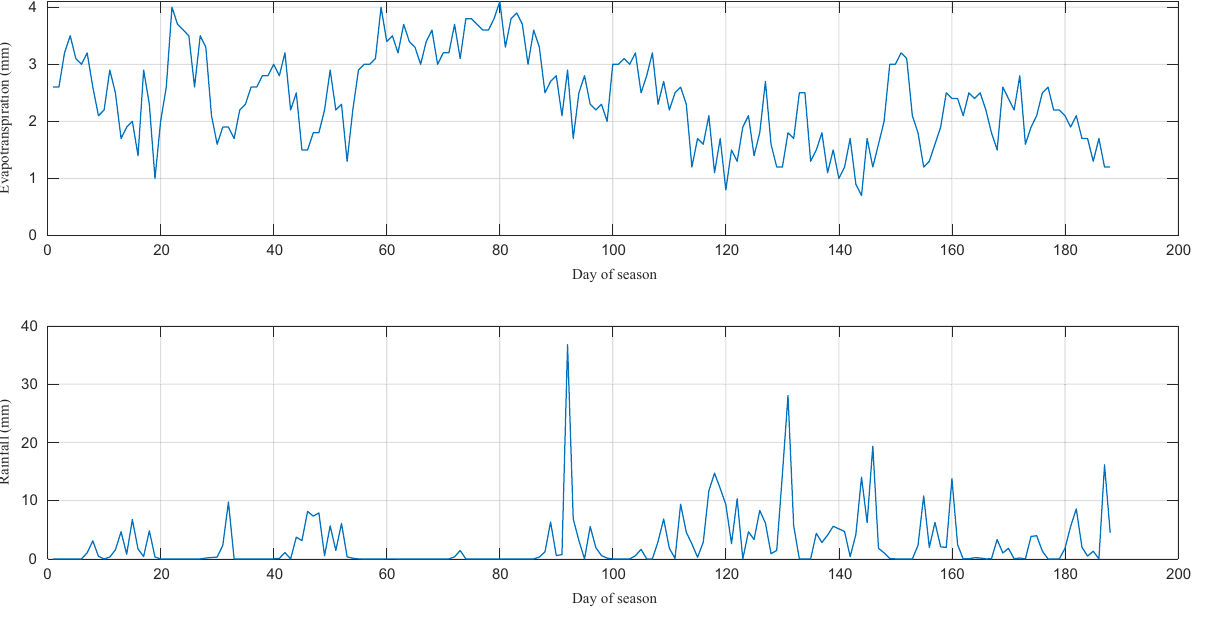
Figure 11: Rainfall and evapotranspiration in the Year 2020.